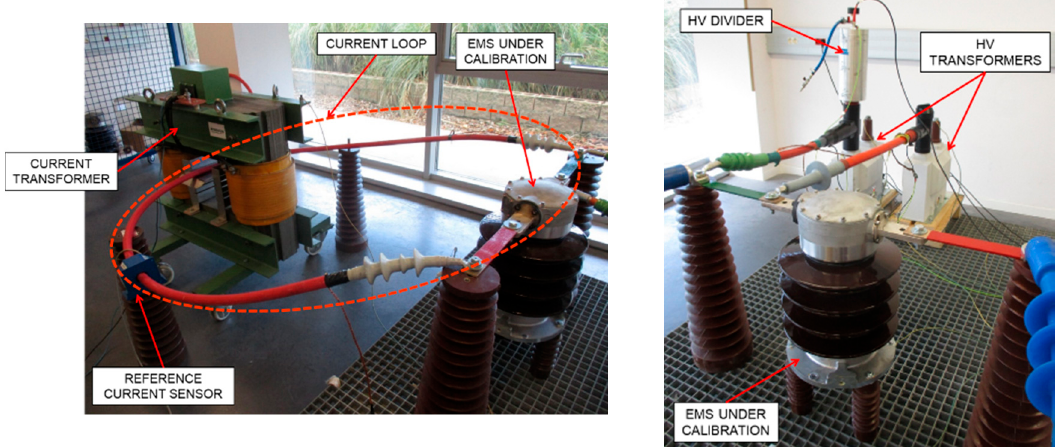
Figure 7. Lay-out of the high current circuit and the high voltage circuit when an EMS is under calibration.